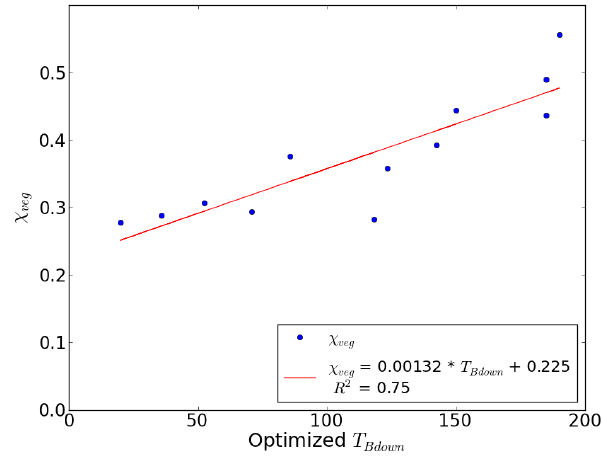
Figure 13. Relationship between the average T B,down of the three frequencies and the proportion of pixels occupied by vegetation (trees) in the fisheye pictures ( χ veg ) for the 12 JB veg sites in January and